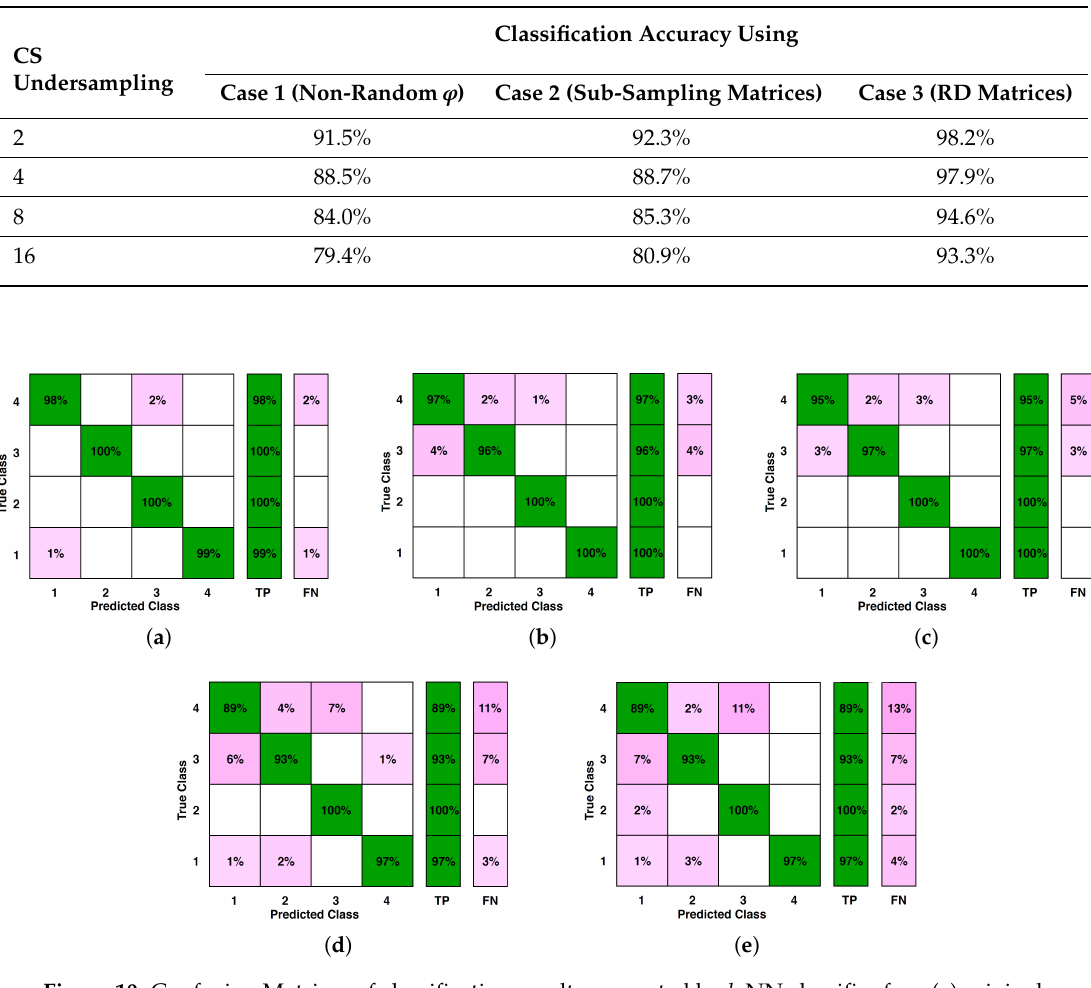
Table 5. Performance comparison of proposed scheme using different sampling matrices tested on the vibration dataset taken from Ladisk [28].